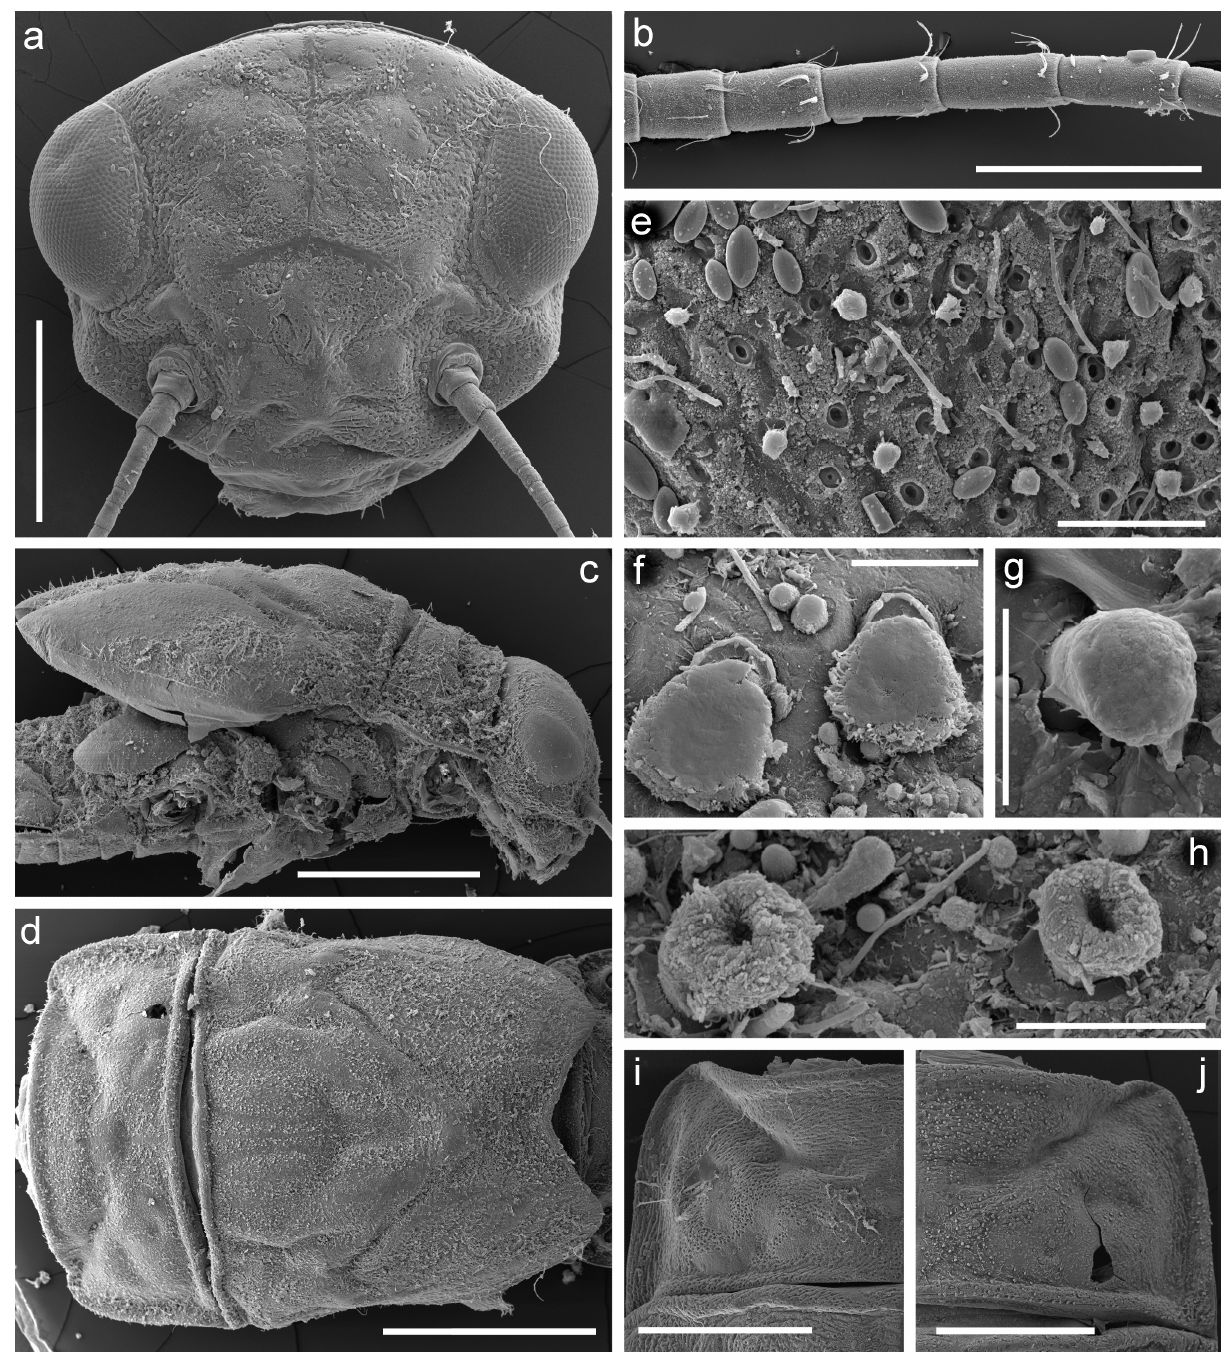
Figure 8. Larva of Torleya elissa (Jacobus, Zhou & McCafferty, 2009). ( a ) Head; ( b ) flagellum, ( c ) thorax, lateral view, ( d ) thorax, dorsal view, ( e ) setae on dorsal surface of pronotum, ( f – h ) setae of pronotum, ( i ) pronotum with a few setae, ( j ) pronotum with numerous setae. Scale bars: ( a , i , j )—0.5